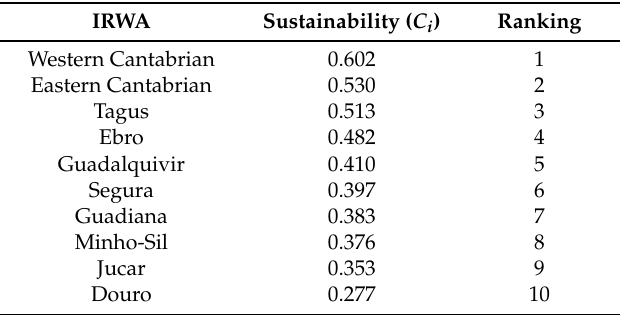
Table 5. Global sustainability of inter-regional water agencies (IRWAs).